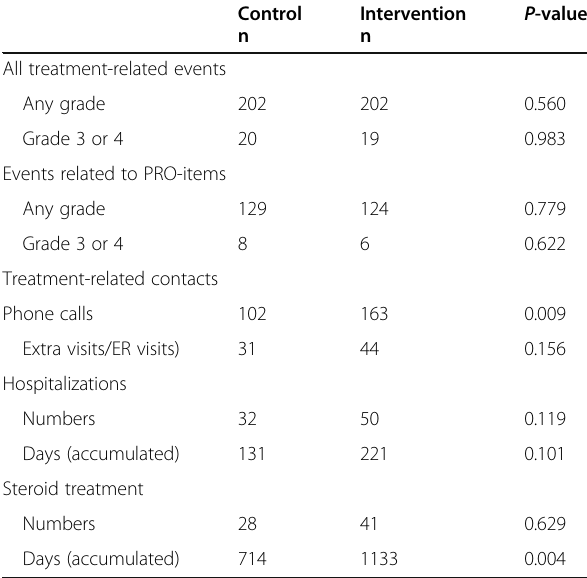
Table 2 Overview of treatment-related events, contacts, days in hospital and days in steroid treatment